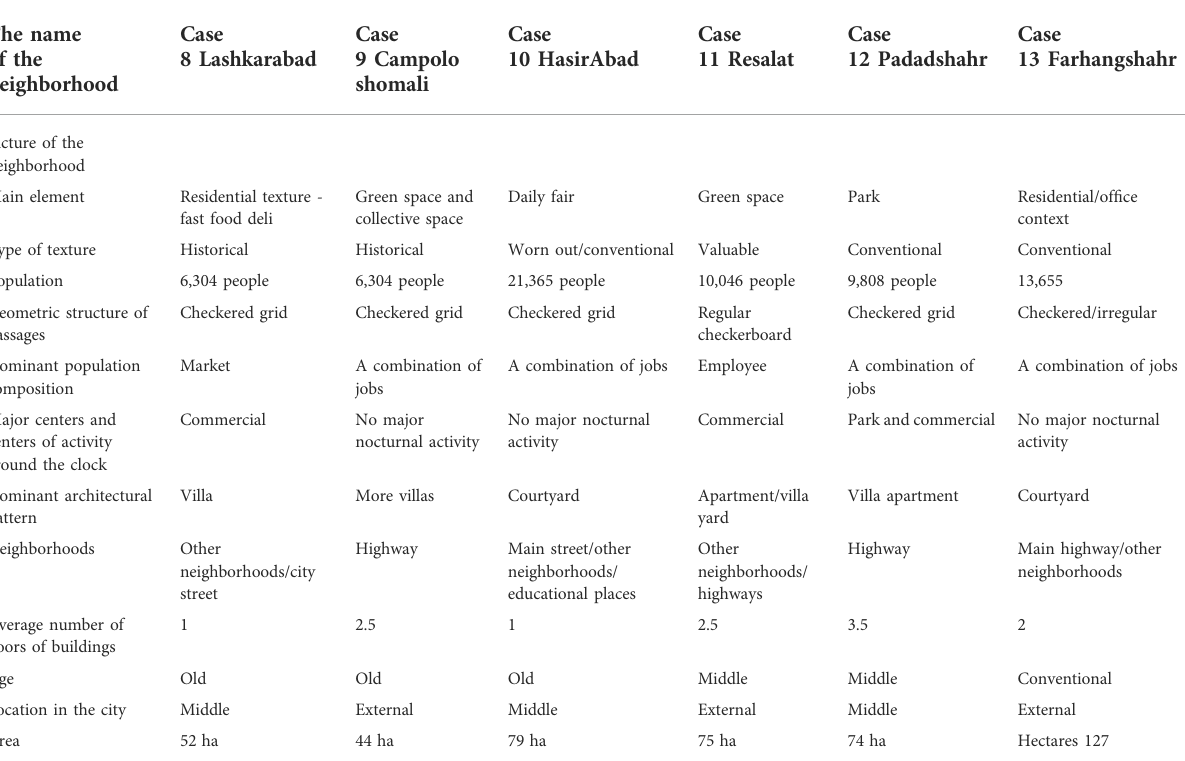
TABLE 6 Case study neighborhoods.